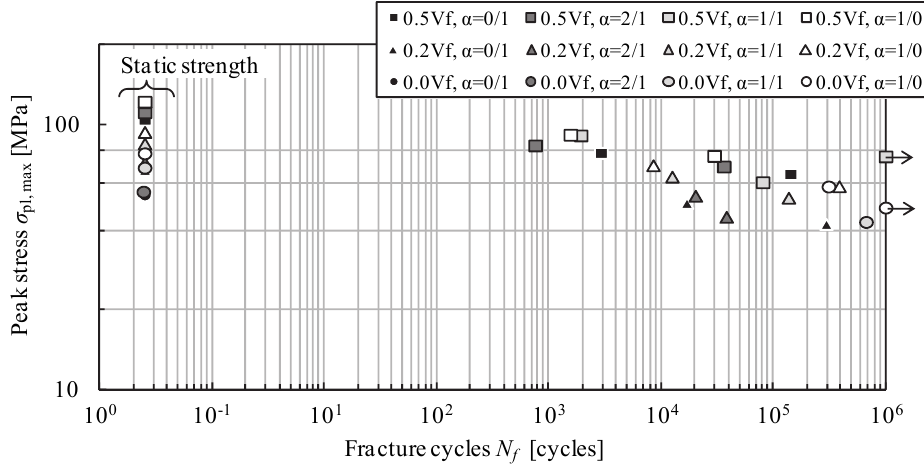
Figure 4: Relationships between σ p1, max and N f with various α in